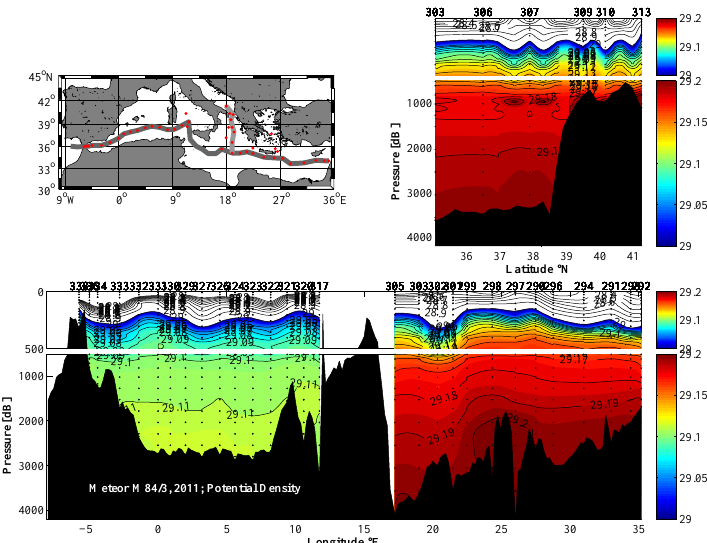
Fig. 5. Similar to Fig. 3, but for potential density ( σ θ ) . No stations are shown in the Atlantic due to the very different densities encountered there as compared to the Mediterranean